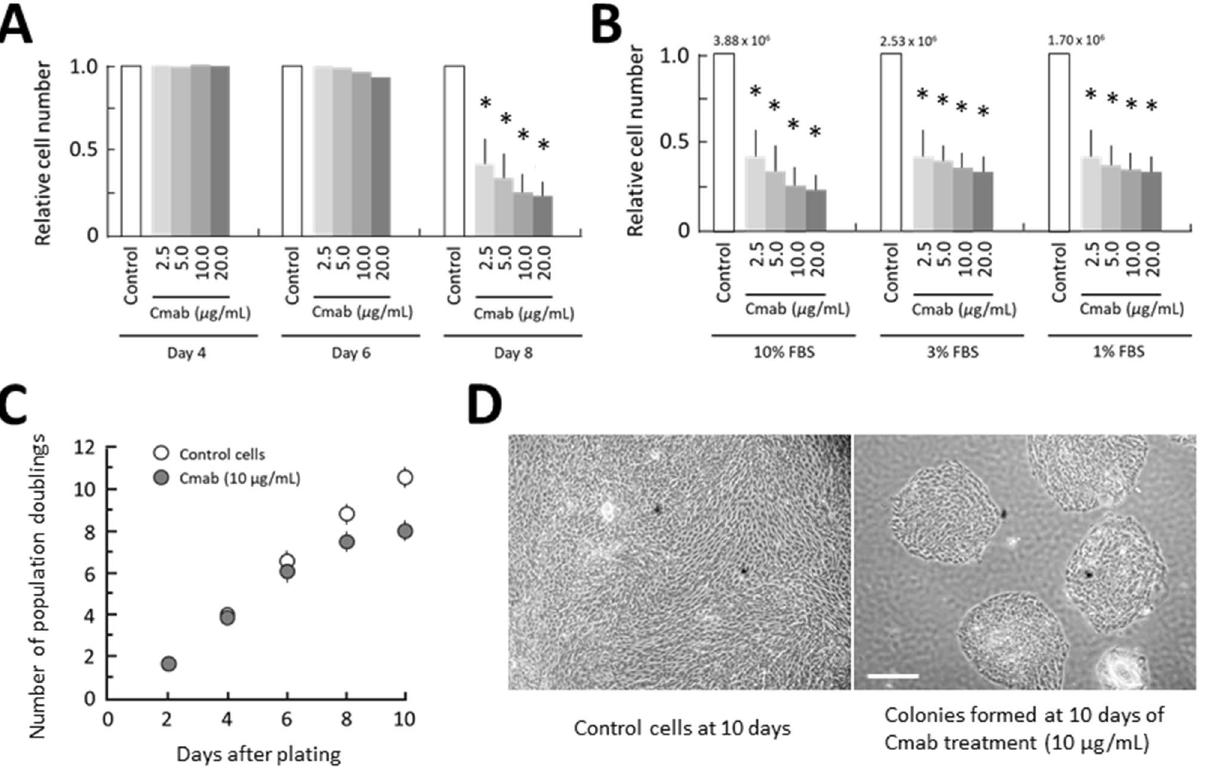
Figure 1. Delayed anti-tumor effect of cetuximab. (A) The anti-tumor effect of cetuximab (Cmab) was not apparent during the first few days of treatment, but dose-dependent growth inhibition was observed by the eighth day of treatment. * p < 0.001. (B) The serum concentration did not block the effect of the cetuximab antibody (10 µg/mL) on day 8. * p < 0.001. FBS, fetal bovine serum. (C) Total cells were counted, and the number of population doublings was calculated every 2 days. (D) The same numbers of cells were plated and cultured for 10 days. The control cells kept growing until they became confluent. In contrast, cells treated with cetuximab (10 µg/mL) showed delayed inhibition of cell growth, such that the arrested cells formed clonal colonies. Data are represented as means ± SD of three independent experiment. Scale bar, 500